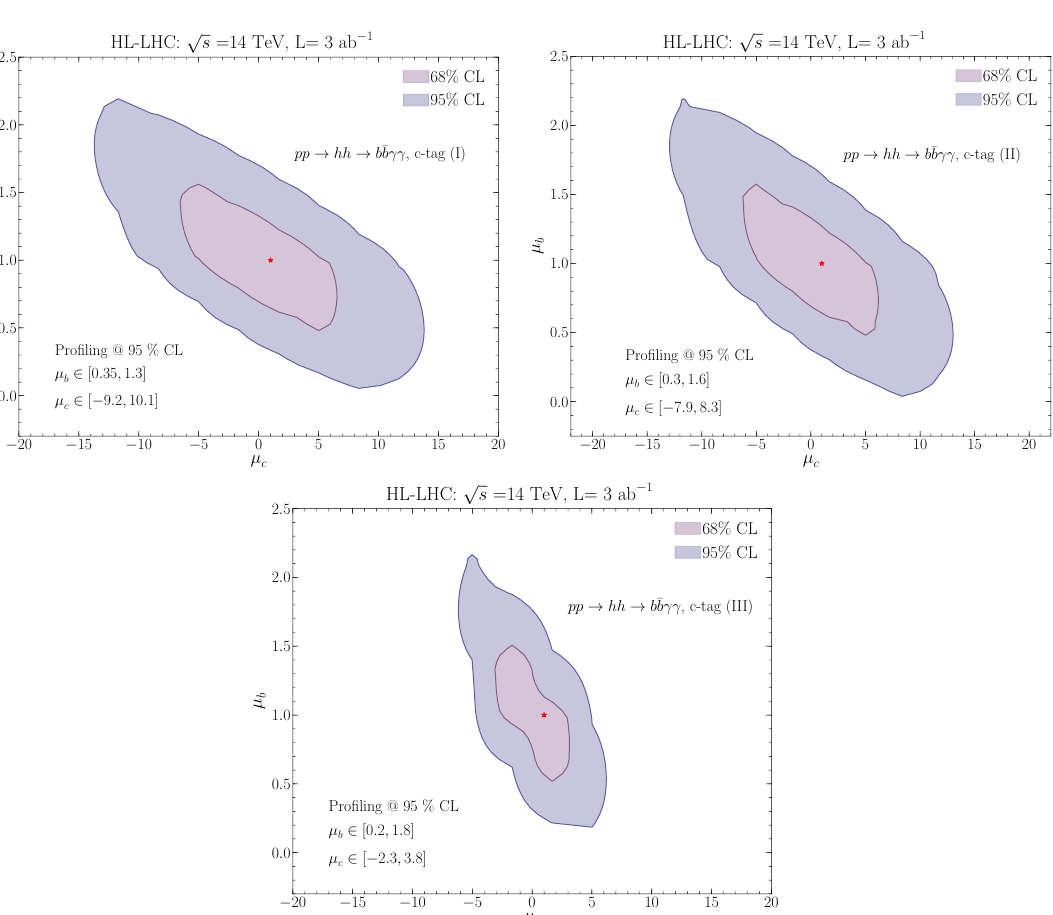
Table 5 . The c -tagging working points with the expected 95% CL upper limit (sensitivity) of (cid:22) c obtained after pro(cid:12)ling over (cid:22) b .